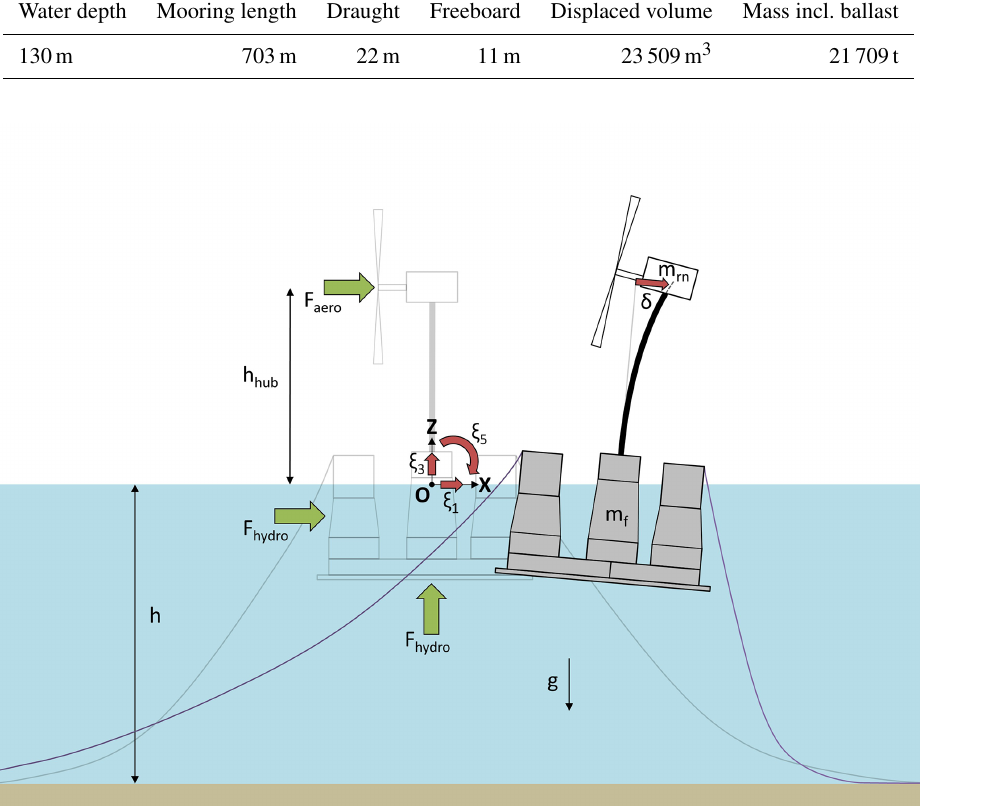
Table 2. Key figures for the OO-Star Wind Floater Semi 10 MW anchored at the selected site.